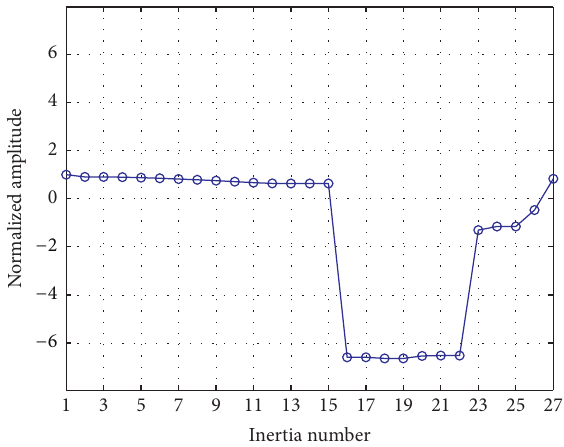
Table 4: Natural frequencies compared between calculation results (using static stiffness) and test results.